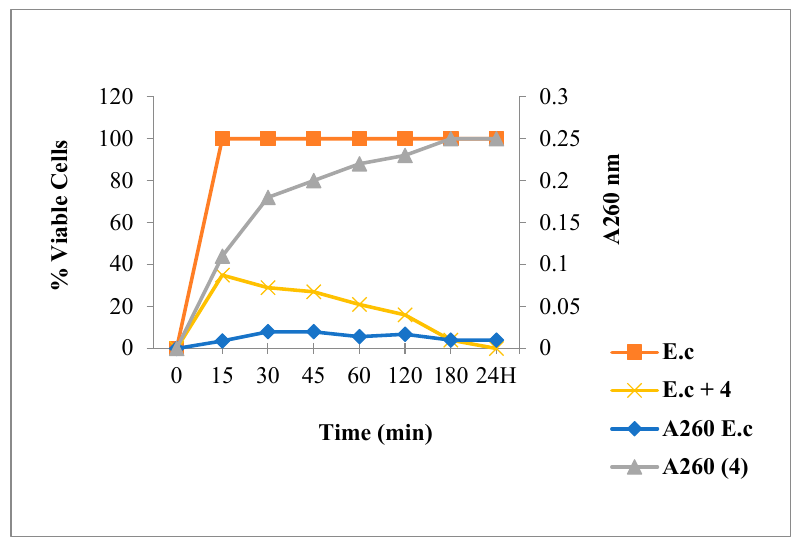
Figure 7. 260 nm absorbent material release and E. coli viability following Colistin ( Col ) treatment.